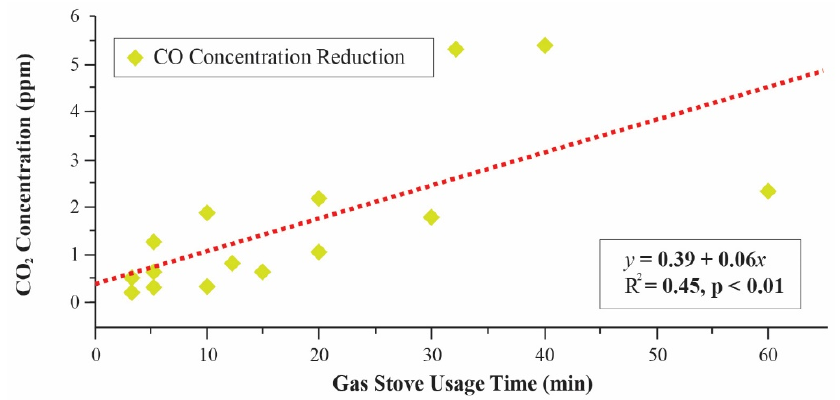
Figure 15. CO concentration by gas stove usage time.